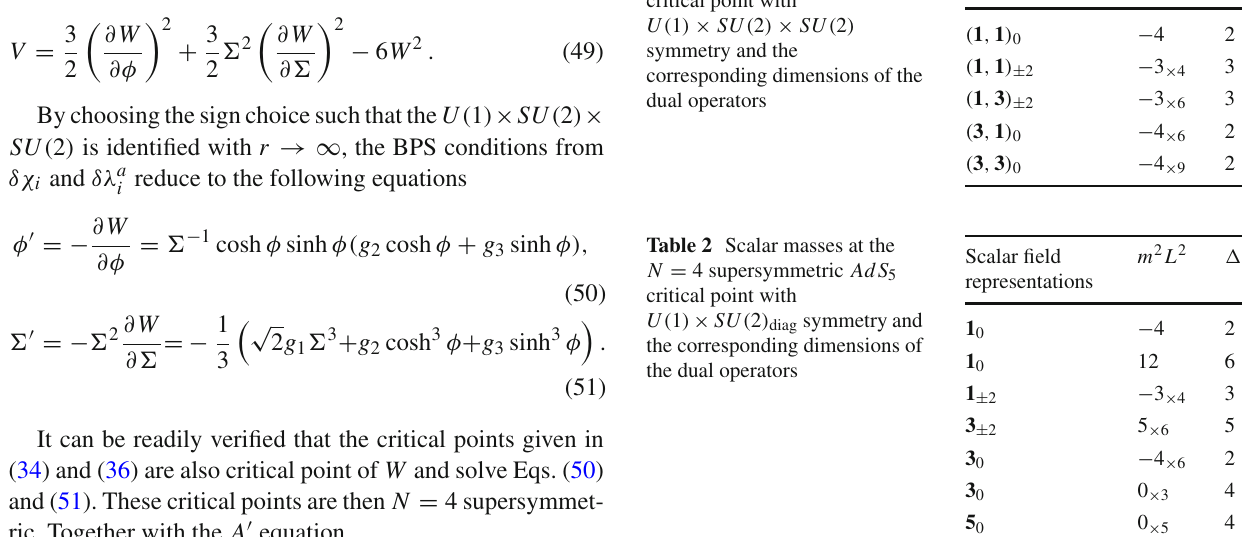
Scalar field representations